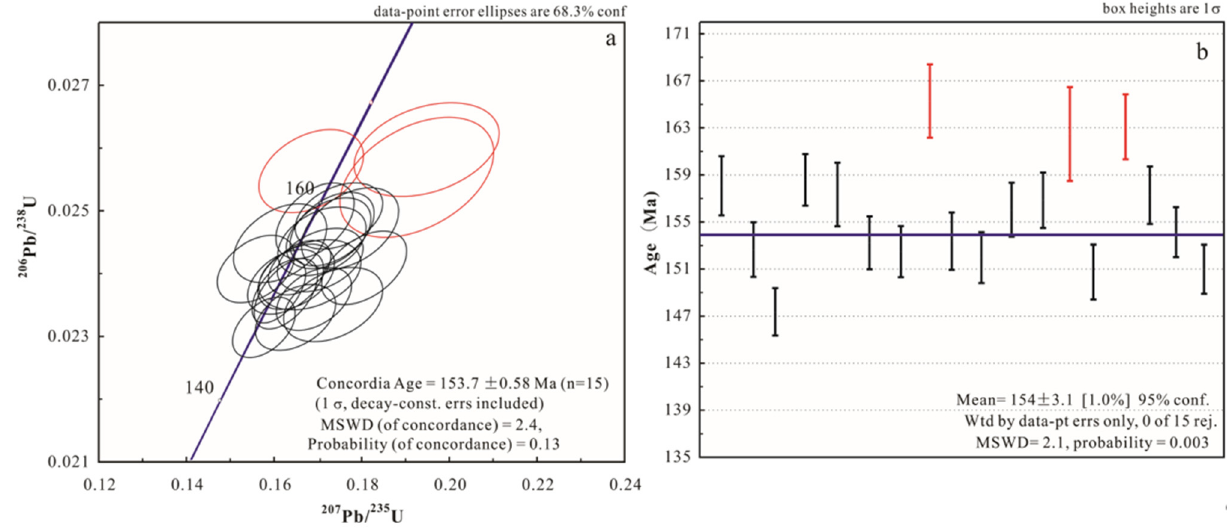
Figure 9. ( a ) Zircon U-Pb concordia diagram and ( b ) the weighted average 206 Pb/ 208 U age of the No. 3 granodiorite. The three relatively older zircons are marked in red colors.